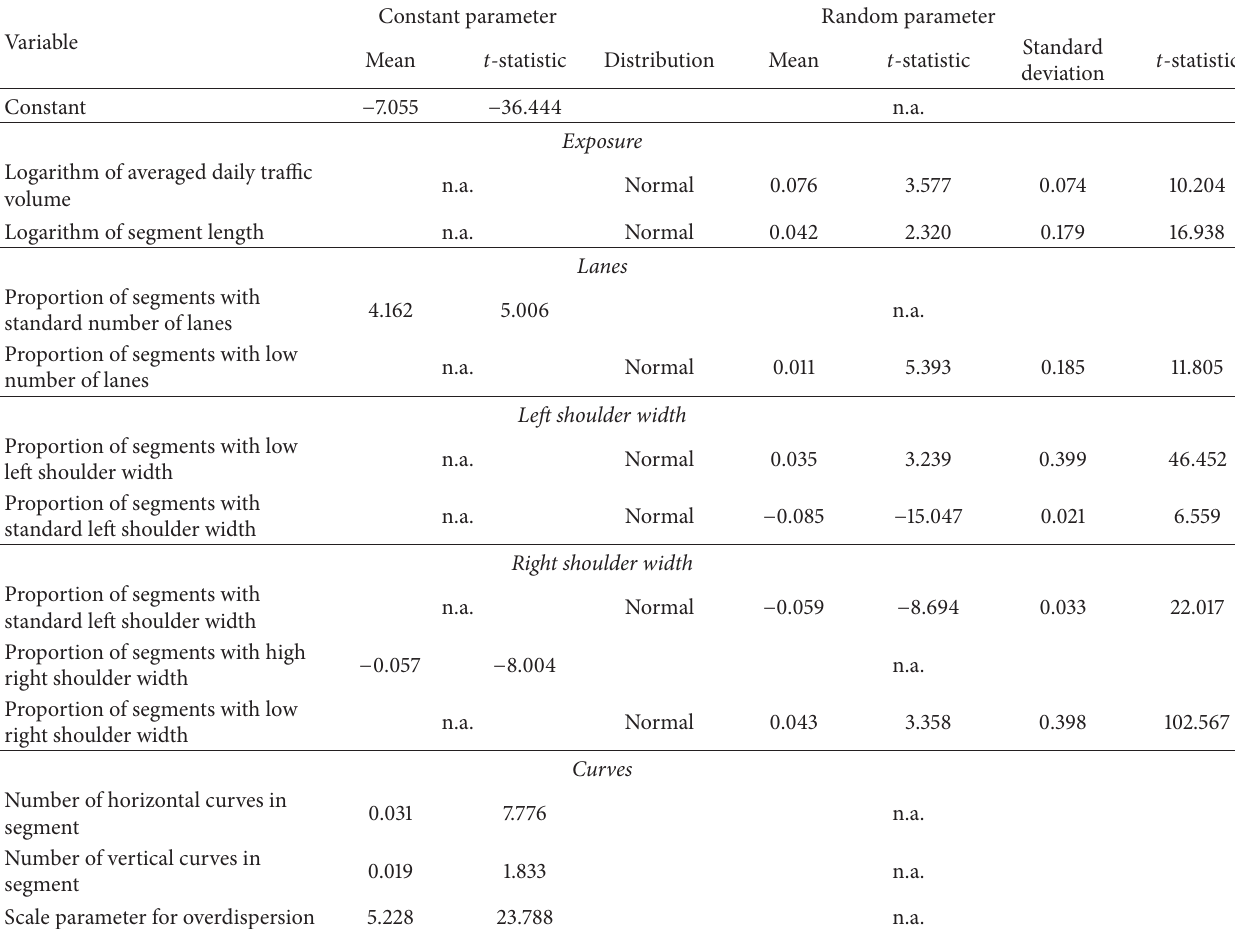
Table 4: Model results for segments without lighting systems.